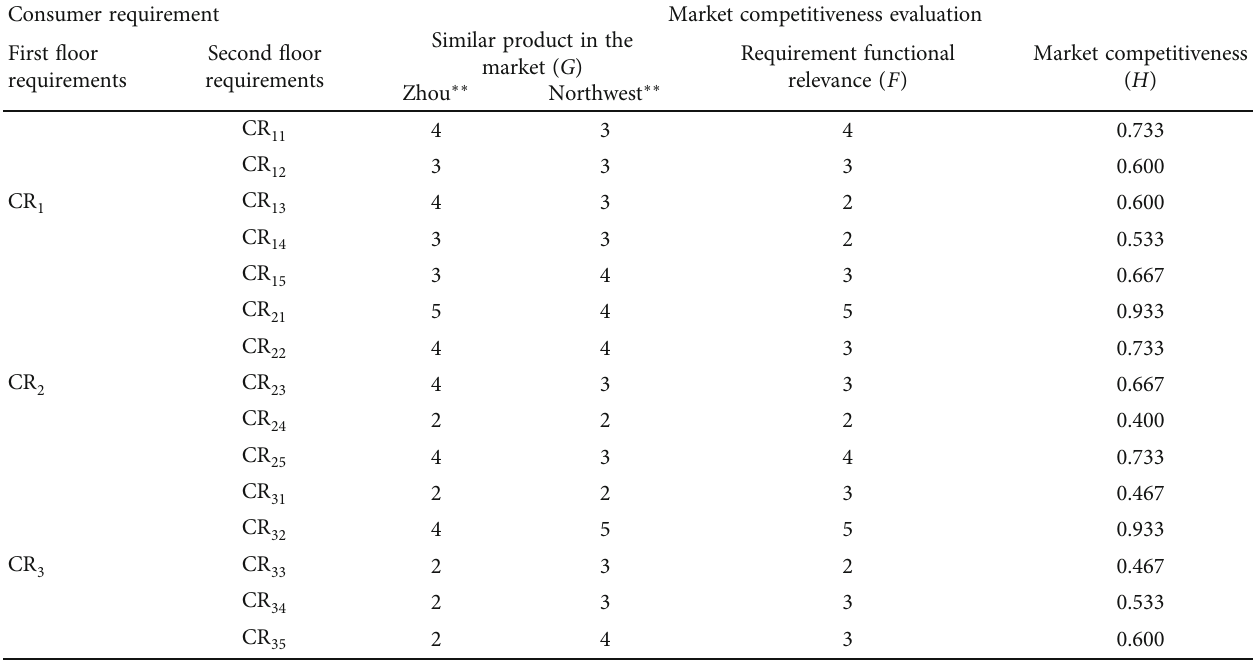
Table 7: Market competitive advantages of each requirement.